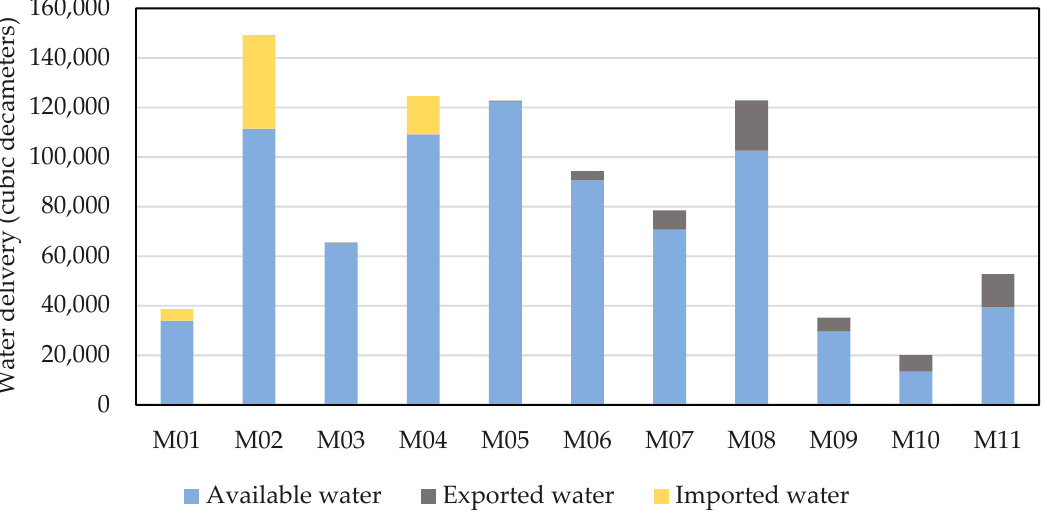
Figure 3. Breakdown of water use under 25% shortage scenario with water market.